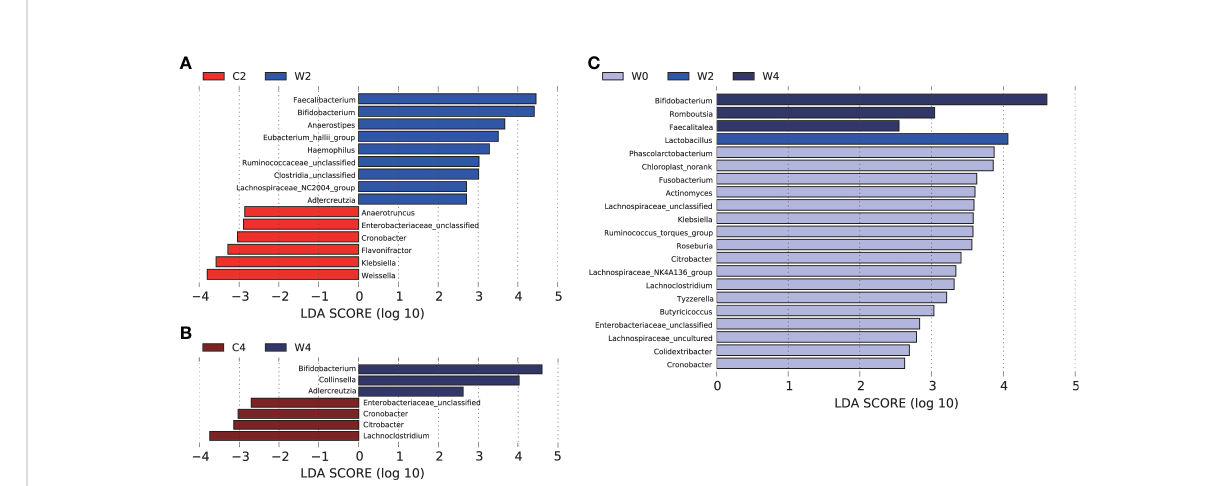
FIGURE 4 LEfSe analysis of differentially abundant taxa in the genus. Histogram of the LDA scores computed for features differentially abundant between gut microbiota. LEfSe scores can be interpreted as the degree of consistent difference in relative abundance between features in the two classes of analyzed microbial communities. The histogram thus identi fi es which clades among all those detected as statistically and biologically differential explain the greatest differences between communities.In this study, LDA=2 was used as the cut-off point. Differences in the gut microbiota in Groups C and Group W after 2 months of intervention (A) . Differences in the gut microbiota in Groups C and Group W after 4 months of intervention (B) .Differences in the gut microbiota between pre- and post-intervention in Group W (C)